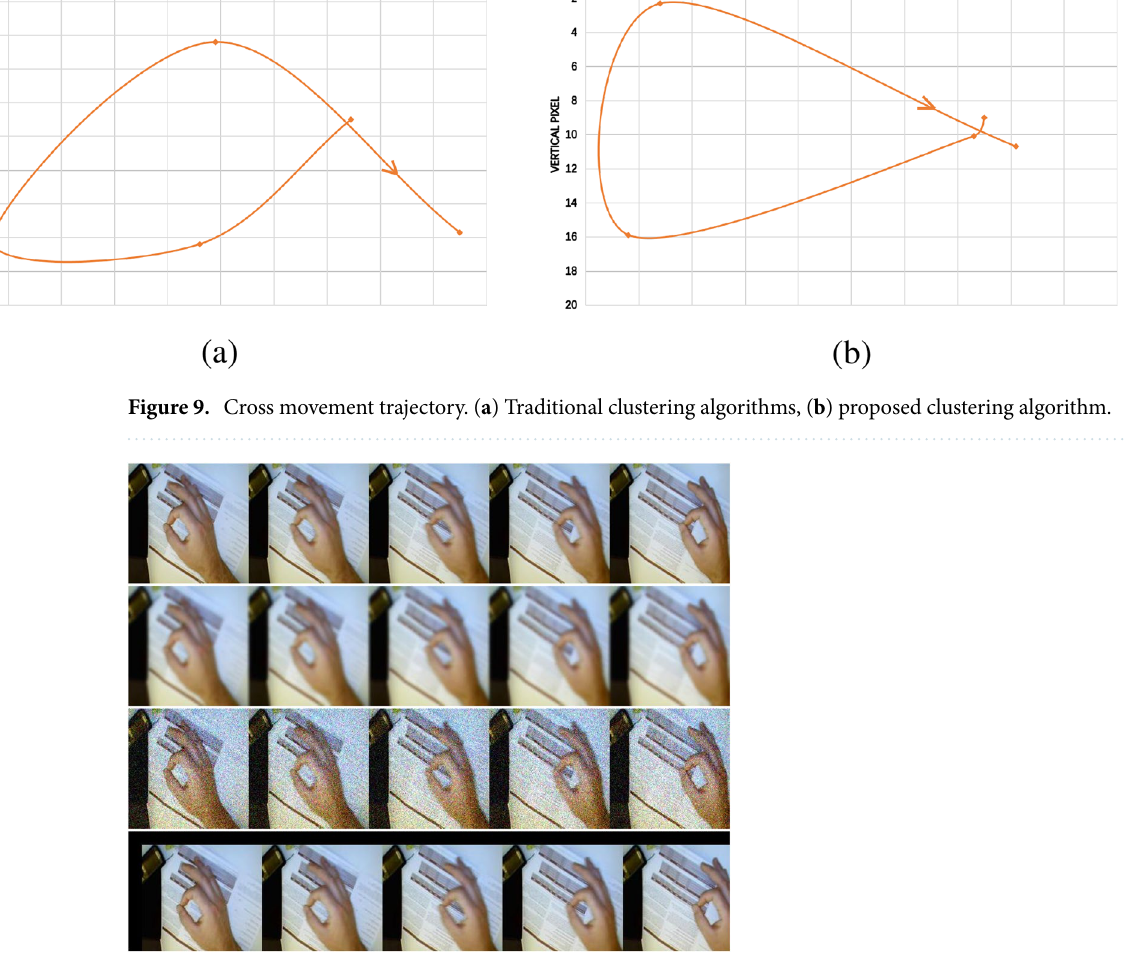
Figure 10. Data enhancement. From top to bottom: original image, blur operation, add noise, translation